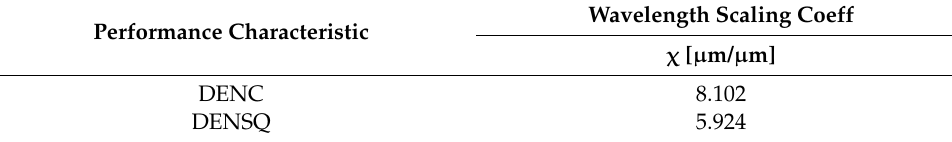
Table 8. Wavelength Scaling Coefficients.